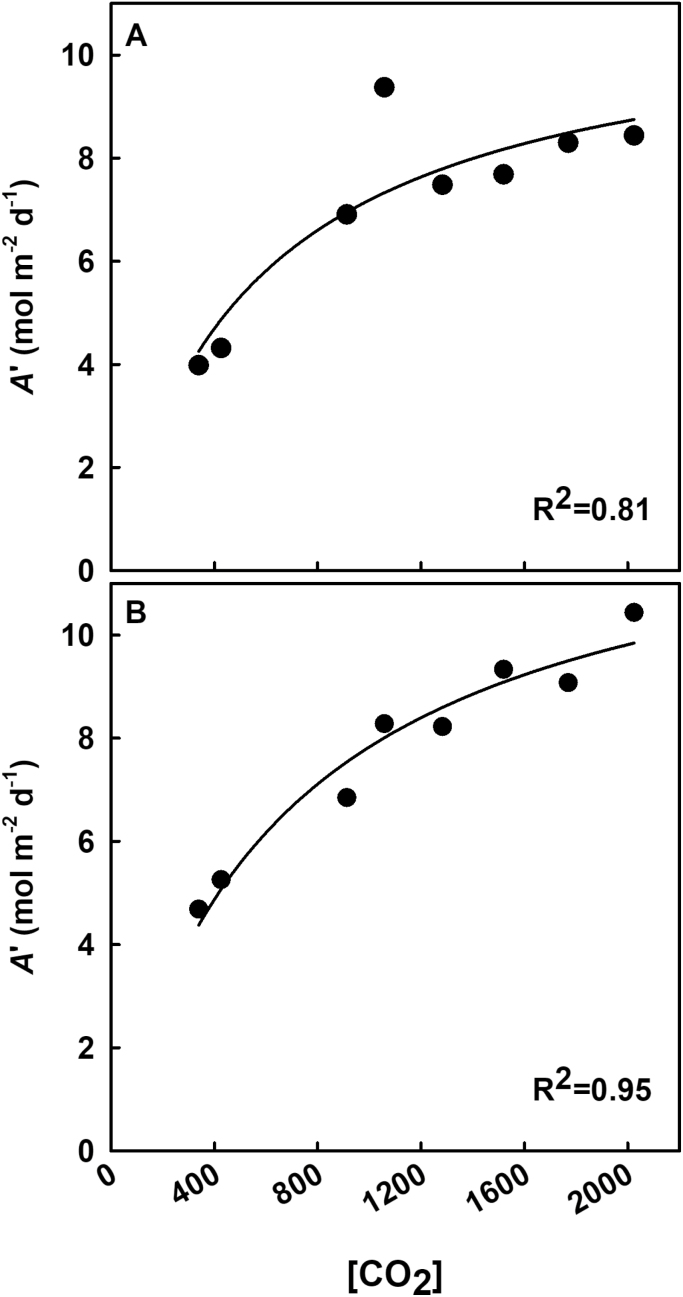
Integrals of daily photosynthesis as a function of [CO2]. Integrals (A') were calculated from diurnal measurements conducted on (A) 20 March (18 DAE) and (B) 3 April (32 DAE). Each point represents the average from each treatment. Statistically significant relationships (P<0.1) as a function of [CO2] are indicated by a fit plotted through the data. R2 values are indicated in the figure.